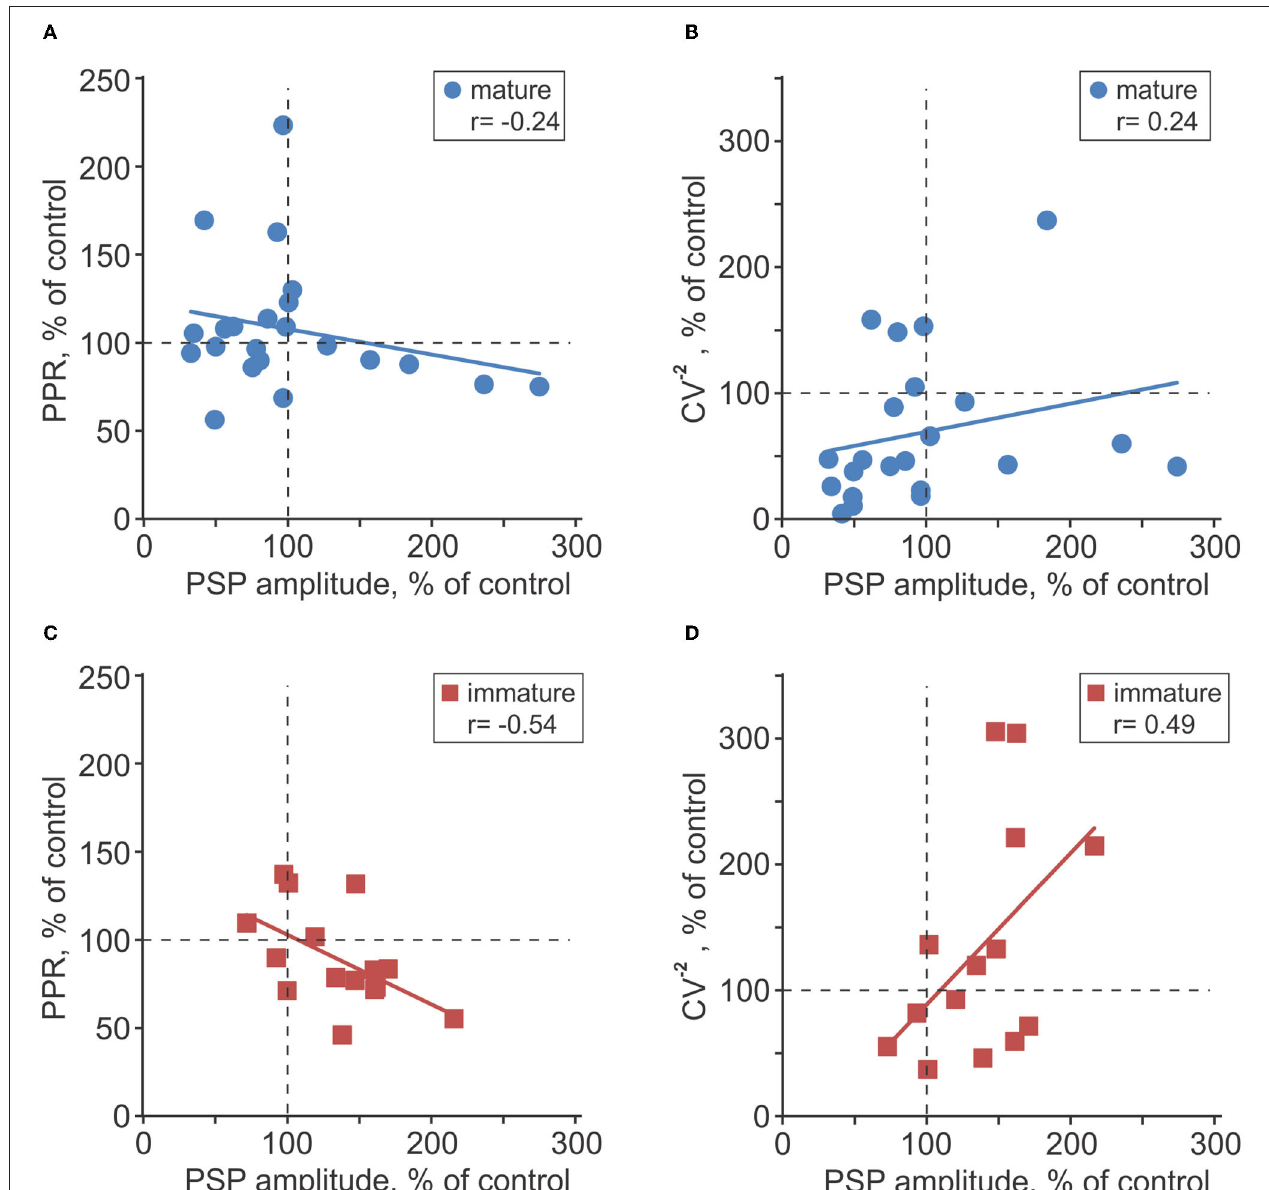
FIGURE 7 | Changes of release probability indices associated with plasticity in mature and immature neurons. (A–D) Changes of the paired-pulse ratio [PPR; (A,C) ] and inversed coefficient of variation [CV − 2 ; (B,D) ] plotted against PSP amplitude changes after intracellular tetanization in n = 23 mature (A,B) and n = 15 immature (C,D) neurons. All changes are calculated in percentage of respective values in control, before intracellular